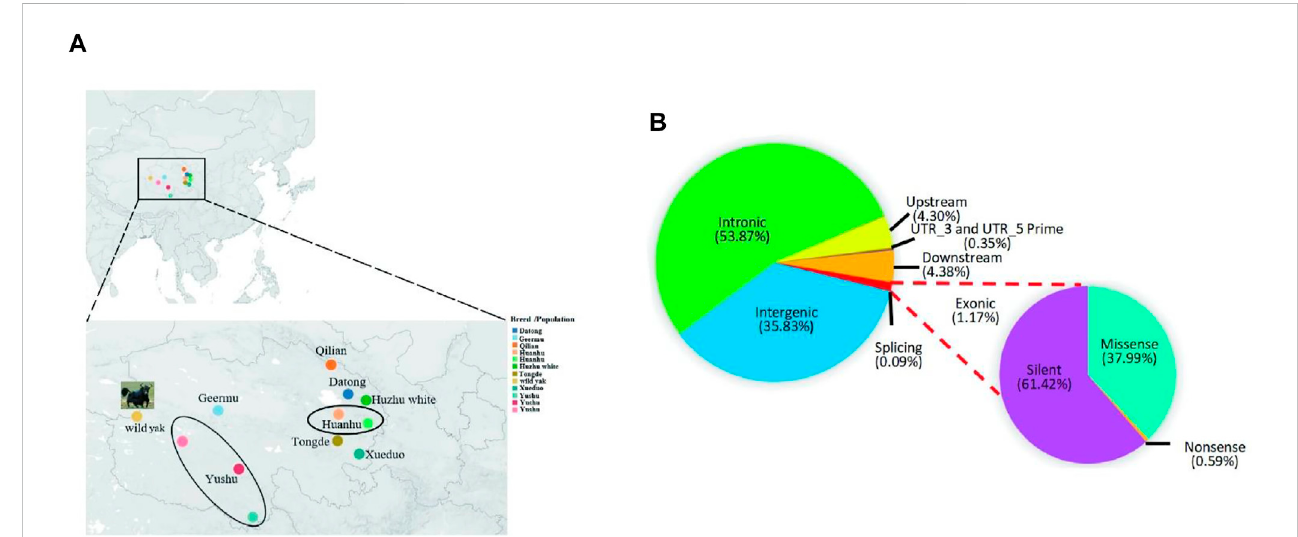
FIGURE 1 Distribution of samples of Qinghai yak breeds/populations and SNPs in yak genome. (A) Sampling sites and geographic distributions of nine Qinghai yak breeds/populations. (B) Distribution of detected SNPs in the genomes of nine yak breeds/populations. The circles represent the sampling ranges of Huanhu and Yushu